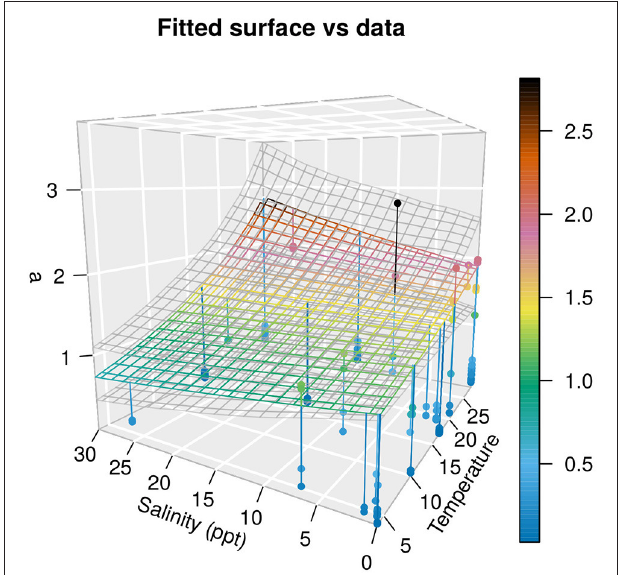
FIGURE 3 | Resistance time in days ( Rt ) until 90% of the virus is inactivated in response to temperature and salinity. Color scale is for reference and indicates the estimated Rt with 95% credible intervals obtained with the posterior parameter samples (gray planes above and below the color